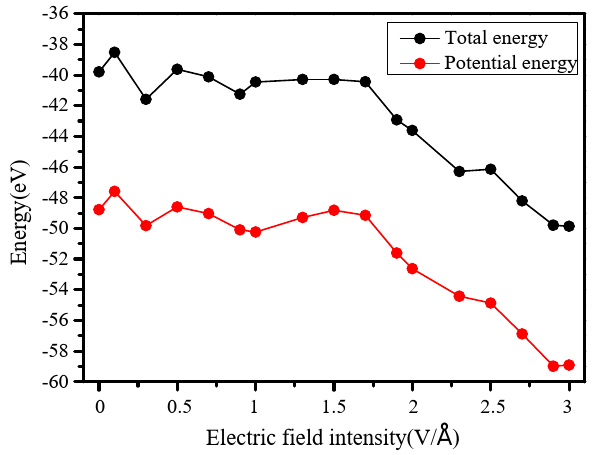
Figure 5. Changes of total and potential energy constant.